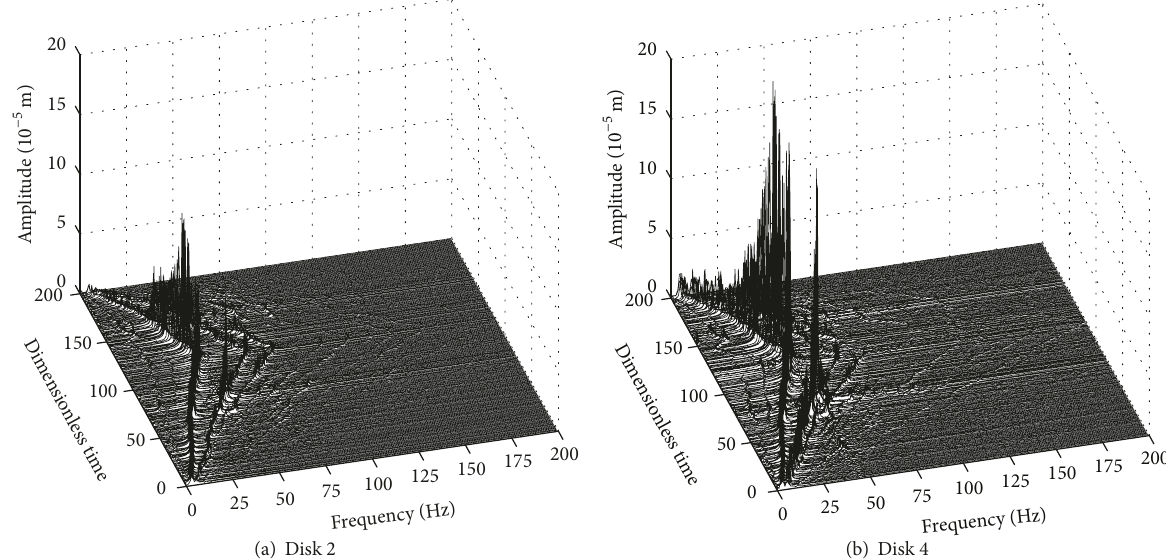
Figure 7: Spectrum cascade of the horizontal response of disks 2 and 4, experimental results. 𝜆 = 1.65 .